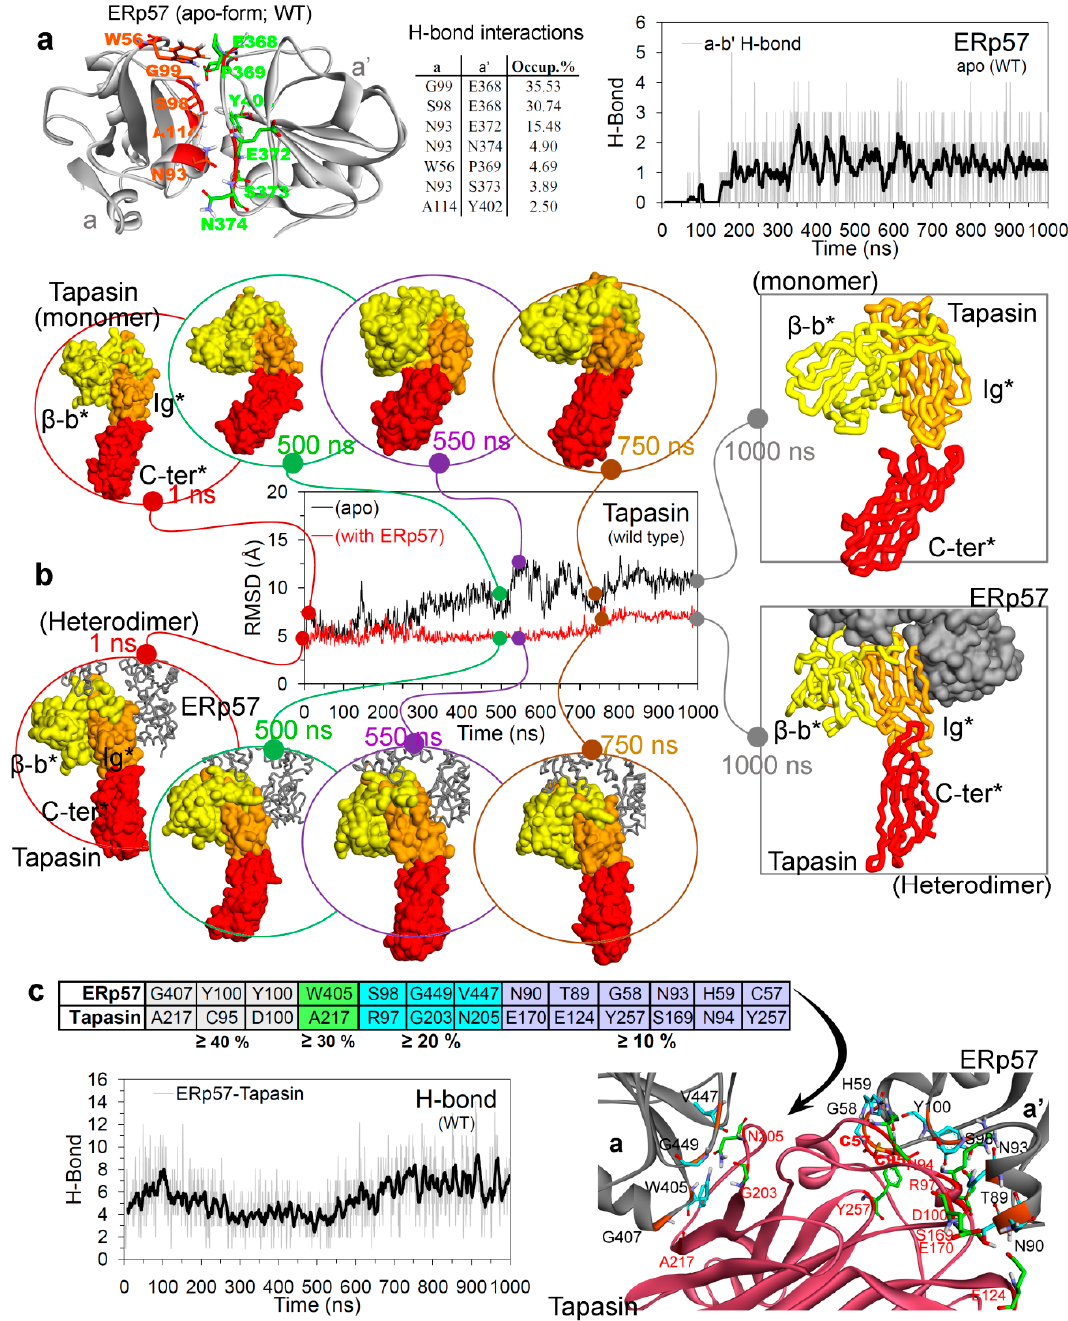
Figure 4. Closed conformation of ERp57 (apo state) and H-bond interaction between ERp57-tapasin. ( a ) Hydrogen bond interactions between the a and a’ domain of wild-type ERp57 in apo state, residues forming interactions with occupancy ≥ 1% are highlighted. Colour scheme: oxygen in red, hydrogen in silver, nitrogen in blue, and sulphur in orange. ( b ) RMSD of all-atoms (excluding hydrogen atoms) of tapasin in apo state and complexed with ERp57. Domain motion modes of tapasin structure at di ff erent time intervals are also presented. ( c ) Intermolecular H-bond interactions of ERp57 with tapasin over 1000 ns of MD simulations. In the diagram, interacting pairs of residues are coloured according to their H-bond occupancy over 1000